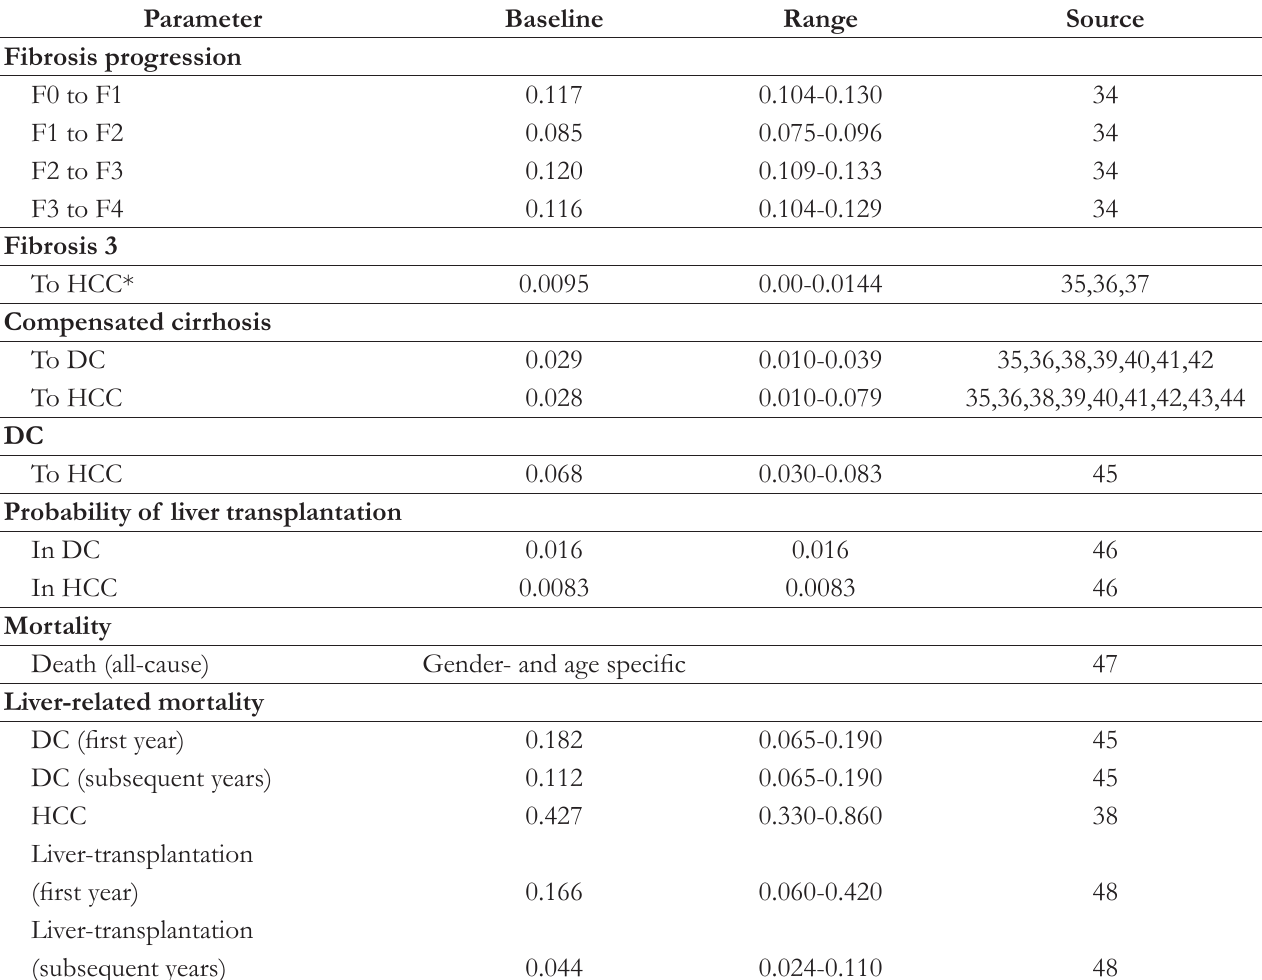
Table 4. Annual Transition